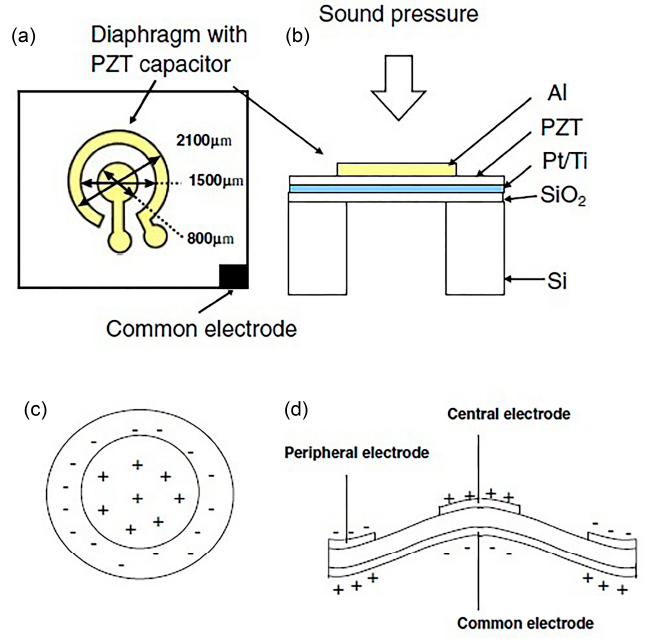
Figure 5. ( a ) Top view and ( b ) cross sectional view of the PZT diaphragm energy harvester. ( c ) Possible charge distribution at first mode and ( d ) the conceptual schematic of peripheral and central energy harvesting [49]. Copyright (2011) The Japan Society of Applied Physics.